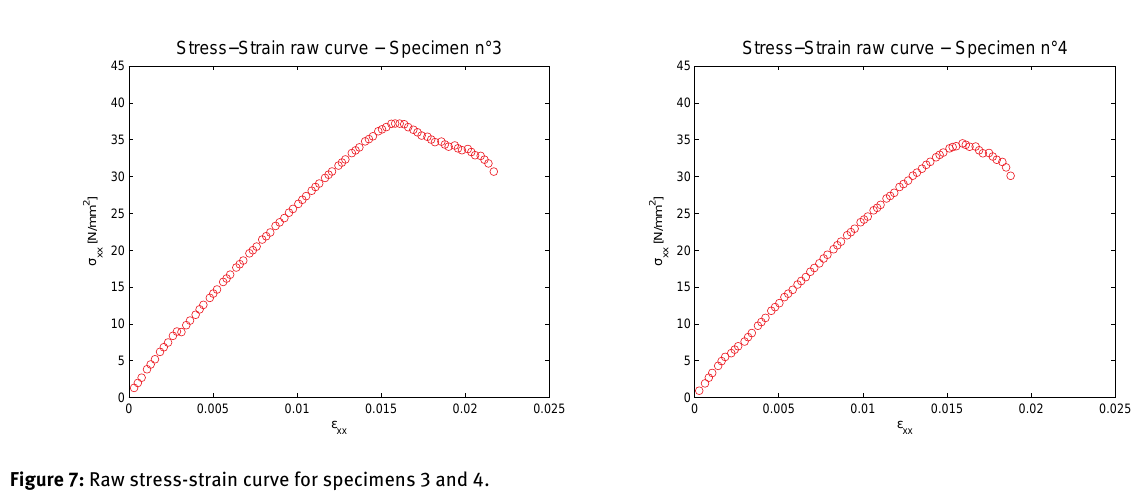
Figure 6: Raw stress-strain curve for specimens 1 and 2.